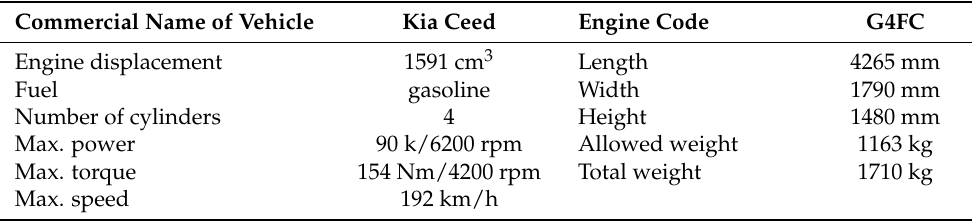
Table 1. The technical data of the laboratory tested vehicle. Source: [30].